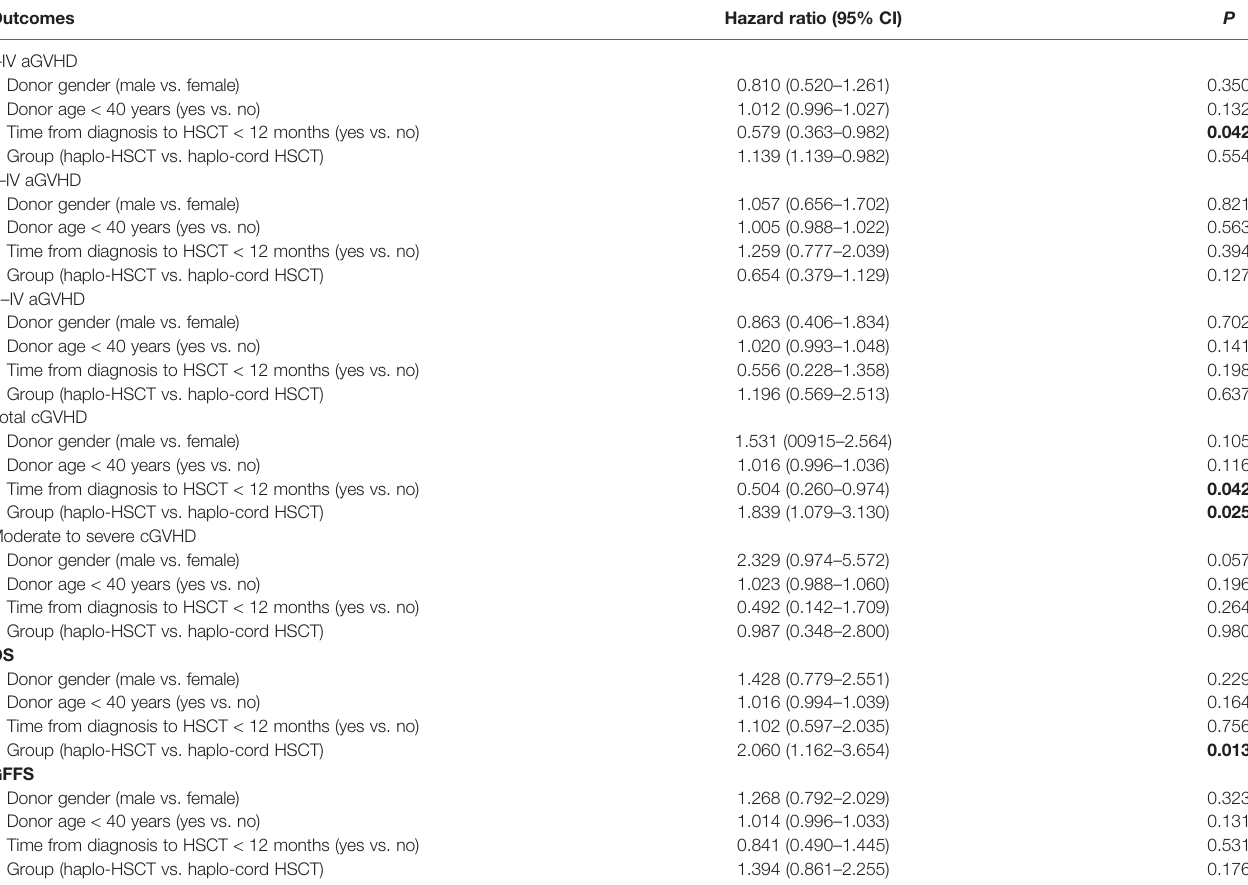
TABLE 2 | Multivariate analysis for GVHD and survival in the whole cohort.